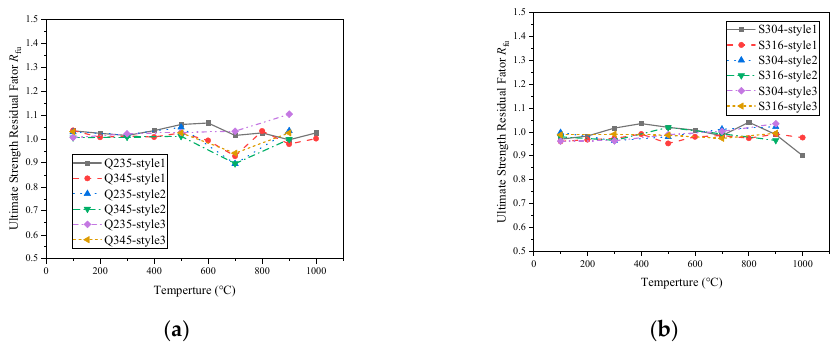
Figure 8. Ultimate strength residual factor. ( a ) Q235 and Q345; ( b ) S304 and S316.